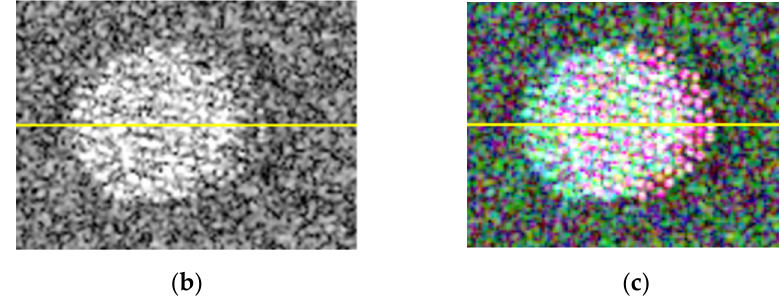
Figure 1. Image of the simulate forest scene image. ( a ) Forest scene; ( b ) Power image of HV; ( c ) Pauli image.